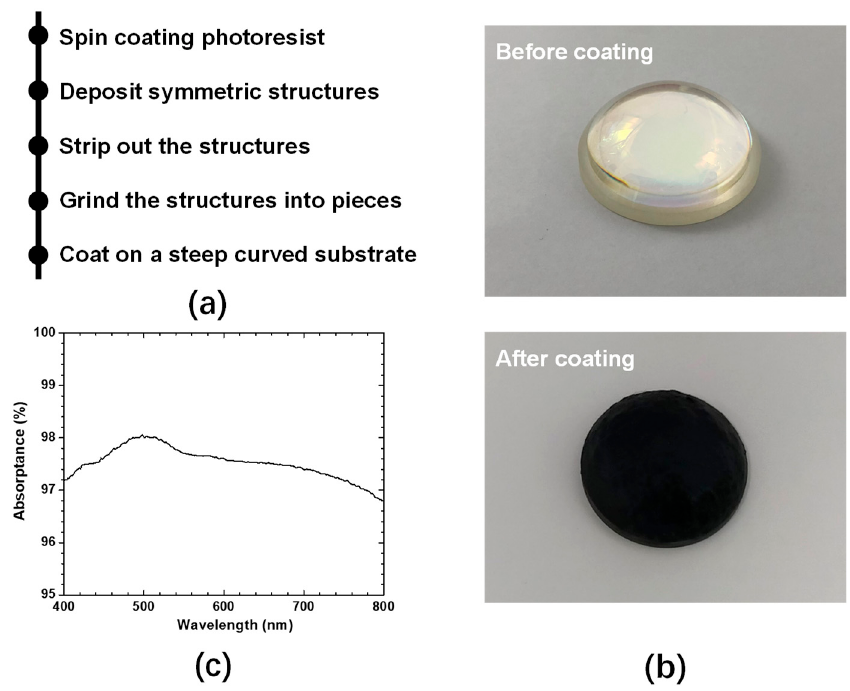
Figure 7. ( a ) The processes of the absorber fabricated on a curved substrate; ( b ) a hemisphere substrate image before and after absorber coating taken under 45° incidence; ( c ) the integrated absorption spectra.